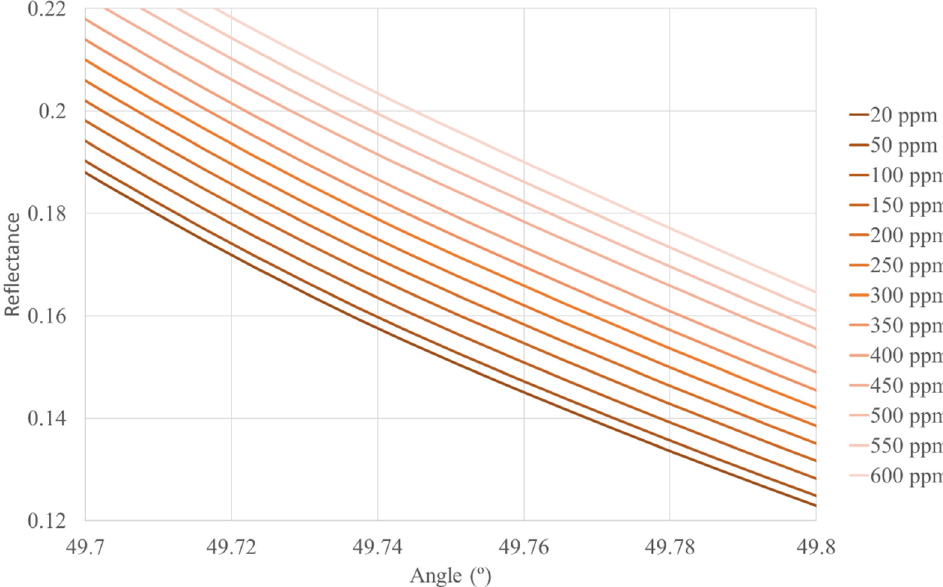
Figure 4. Reflectance curves as a function of the angle of incidence of the light in the hemispherical prism and different concentrations of CO. The height above sea level is 3000 m, 7.01 × 10 7 Pa, 7 °C. The sensor works with an incidence angle of 49.75°.